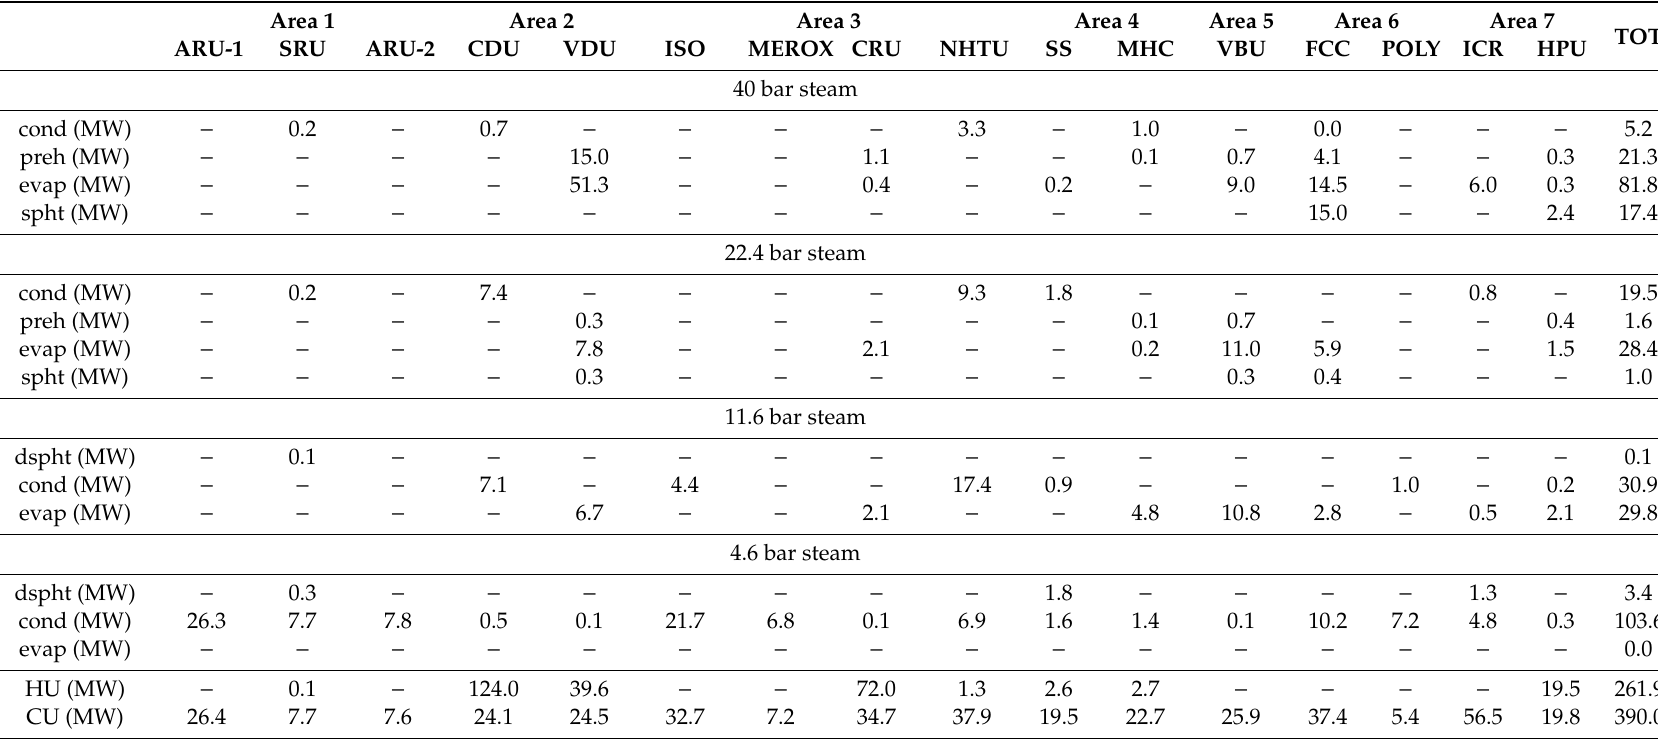
Table 3. Possible optimal steam distribution and production in di ff erent refinery units for the case in which direct process heat integration is allowed within units only and a site wide steam network with turbines is used (case b -4, ∆ T min = 10 ◦ C, power generation = 17.5 MW). Below, cond = condensation, i.e., steam consumption